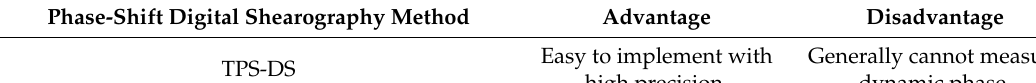
Table 2. A comparison of phase-shift digital shearography methods.